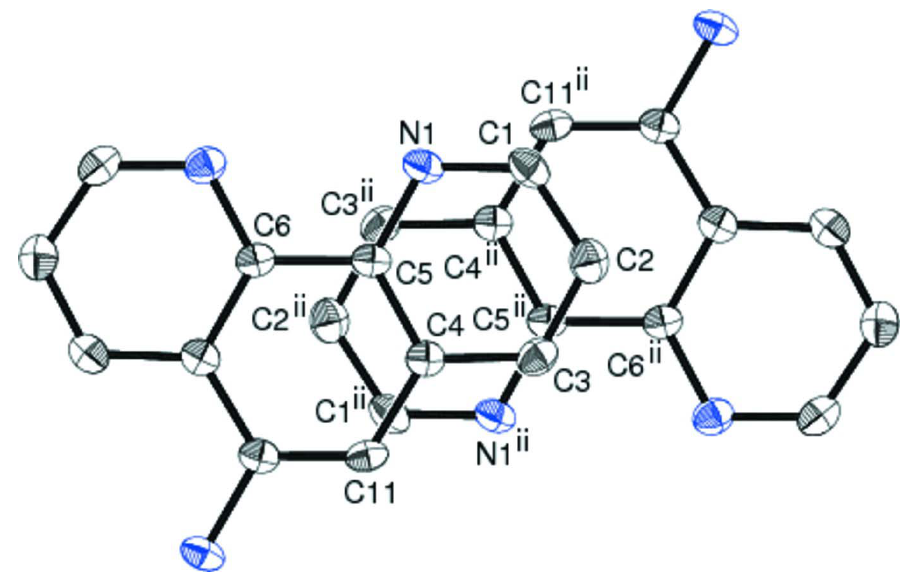
View showing the manner in whch the phen moieties of two symmetry related molecules are stacked, showing a view perpendicular to the planes stacked to each other. Only the labeled atoms are involved in the mean-plane calculations carried out to determine the interplanar separation between the two planes stacked with two different interactions within a one dimensional column. H atoms have been omitted for clarity. [Symmetry codes: (i) 1 - x , 1 - y , 1 - z ; (ii) 2 - x , 1 - y , 1 - z